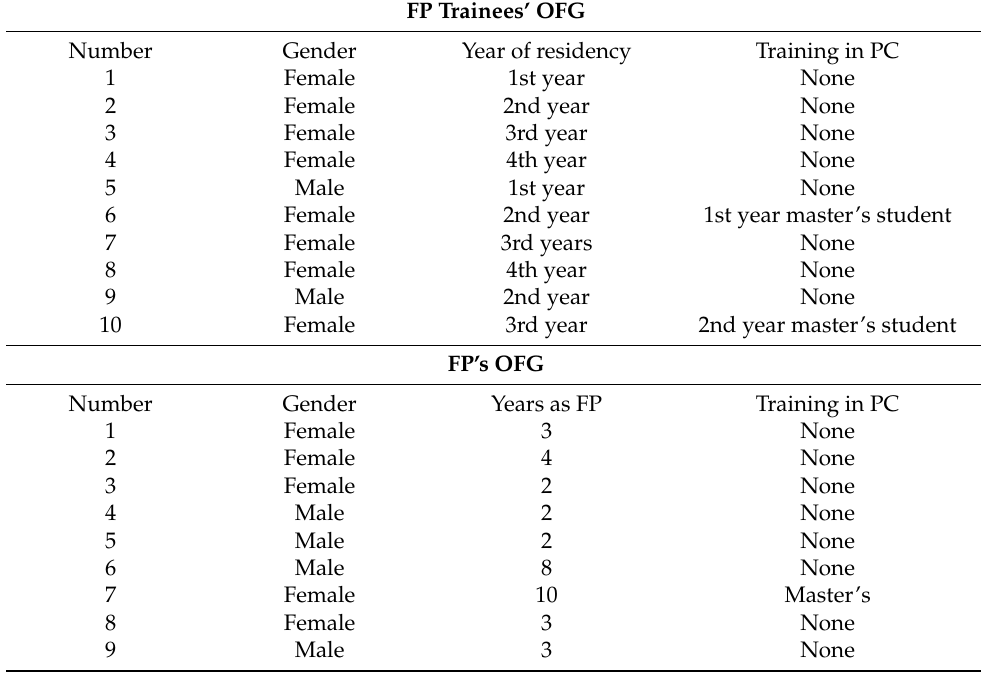
Table 1. OFG participants’ characteristics.